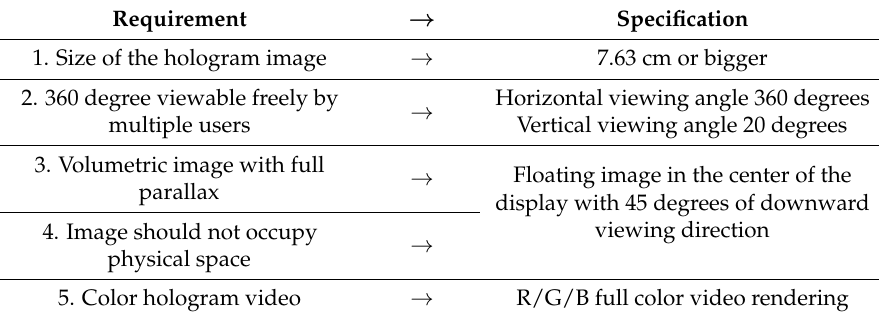
Table 2. Performance specification of the system.